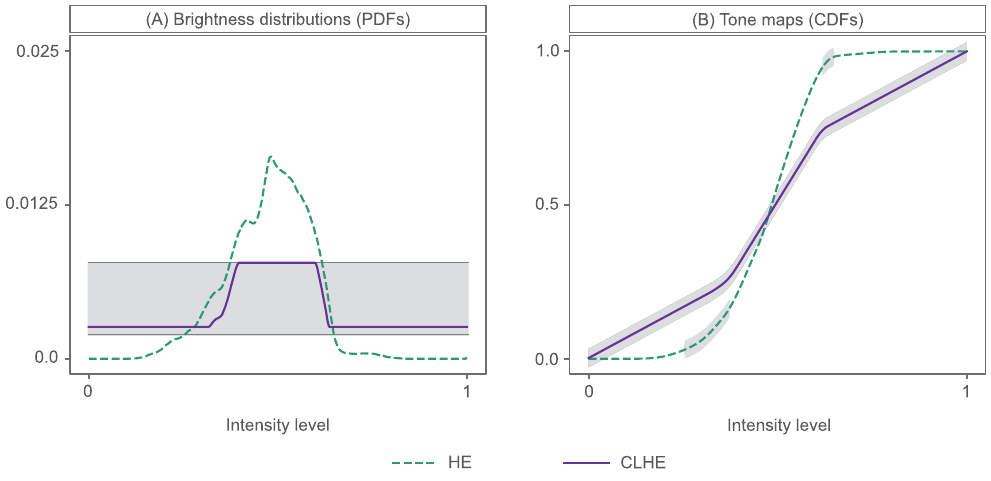
Figure 4. HE & CLHE tone mapping: ( A ) An Input PDF (HE proxy histogram) and its slope-limited (CLHE) proxy, ( B ) their respective CDF’s or tone maps. Grey lines in ( A ) depict upper and lower slope bounds of 2/L and 0.5/L respectively, where L = 256 bins. Grey shading in ( B ) highlights area of each tone map that fall within the slope